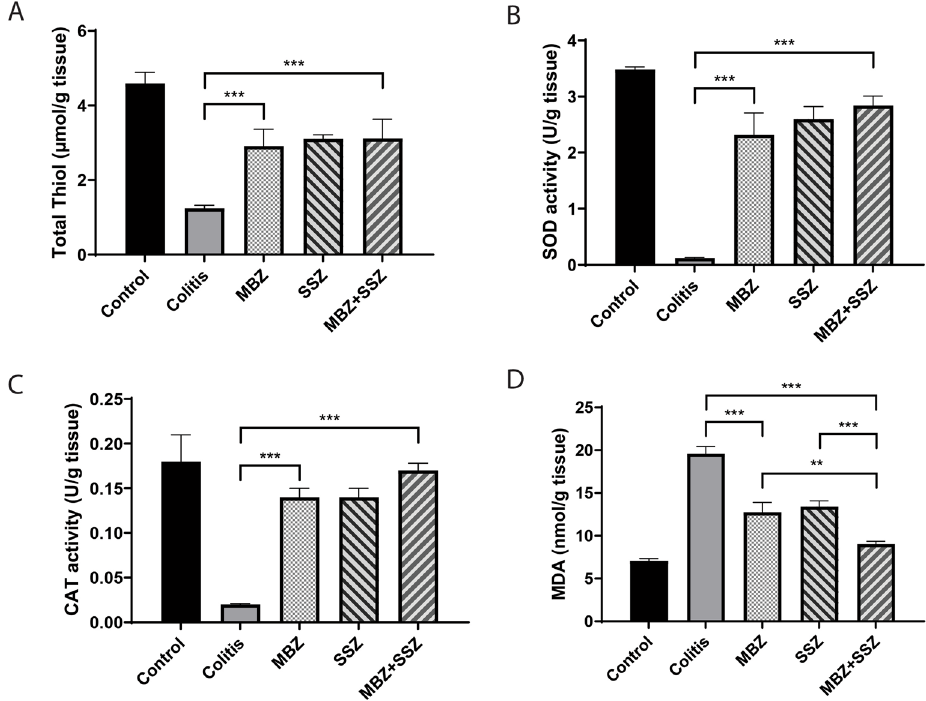
Figure 4. Anti-oxidant effect of mebendazole on colitis. ( A ) Total thiol content, ( B ) SOD activity, ( C ) CAT activity and ( D ) MDA Level, were compared between different groups. * P < 0.05, ** P < 0.01, *** P < 0.001. Data were presented as Mean ± SEM, One-way ANOVA followed by post-hoc LSD test. Data are representative of three independent experiments with 6 mice in each group (n =